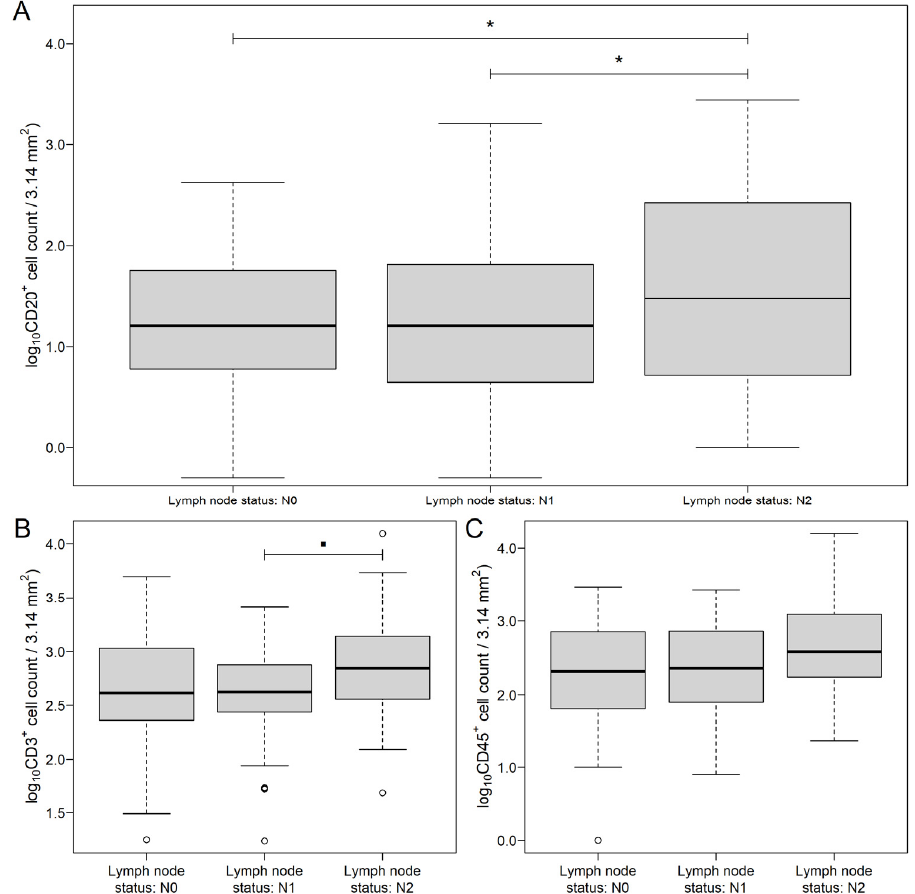
Figure 3. CD20 ( A ), CD3 ( B ) and CD45 ( C ) count data of colorectal cancer samples grouped by lymph node metastasis status. While CD20 was significantly different between the two sides, only marginal differences were justified in the case of CD3 and CD45. The hollow black circles and the thick line represent outliers (greater/less than 1.5 times the interquartile range above/under the upper/lower quartile) and the median value, respectively. * p < 0.05 and ∙ 0.1 < p ≤ 0.05.